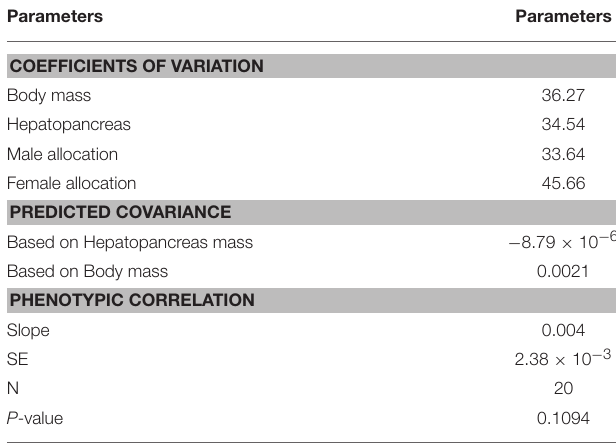
Shown are: coefficient of variation (CV) for the different measurements, the predicted covariance between the sex functions depending on whether resource acquisition variance was based on hepatopancreas or shrimp body mass, and the slope, standard error (SE), sample size (N) and associated P-value when testing for a tradeoff between male and female function. Variances in hepatopancreas, ova and testes mass were calculated from residuals using body mass.